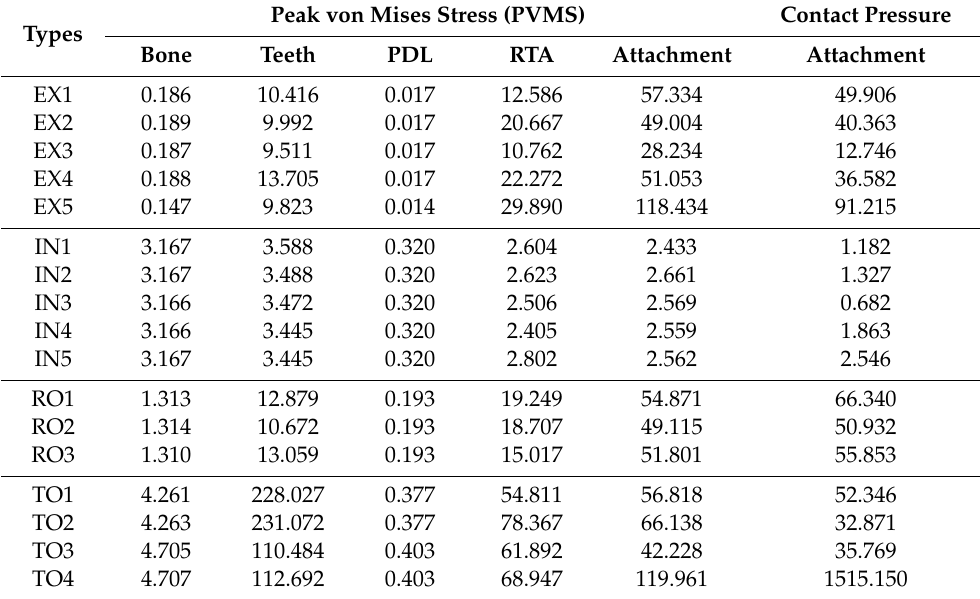
Table 3. The Peak von Mises stress (PVMS) values (MPa) of orthodontic finite element analysis (FEA) models and contact pressure (MPa) of the attachment in four orthodontic treatment